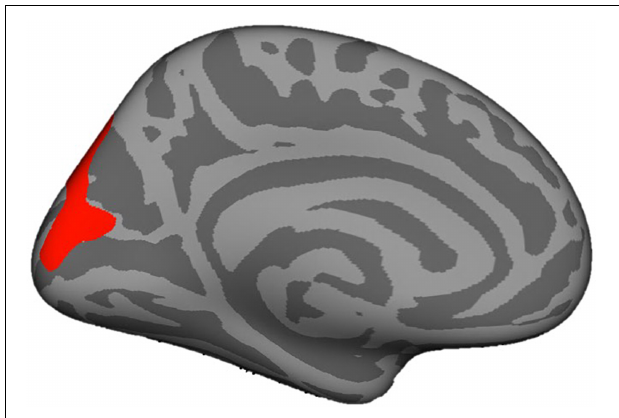
FIGURE 5 | Pericalcarine cortex depicted in